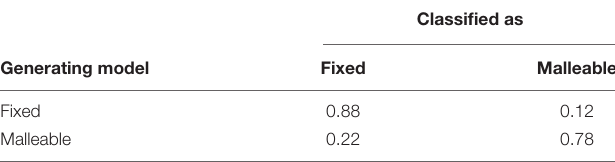
TABLE 5 | Confusion matrix for the MDP mindset classifier.